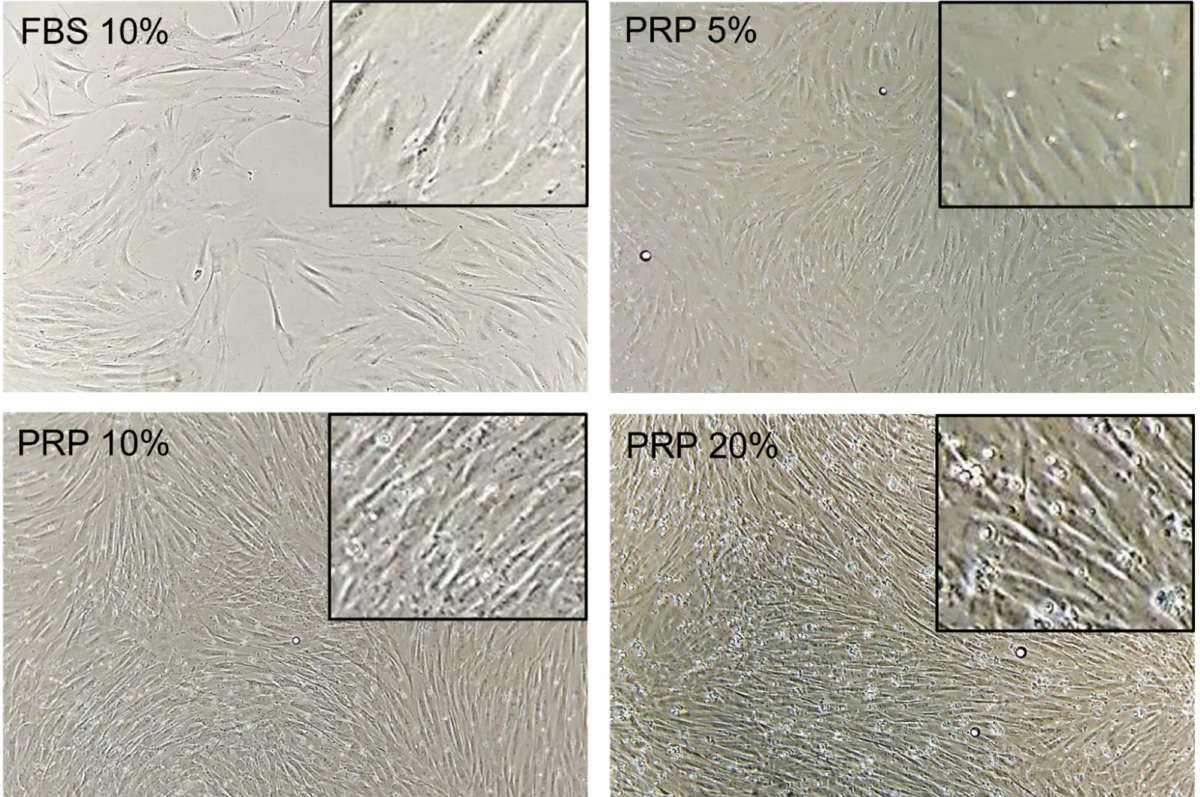
Figure 8. Bright-field optical photography of NHDF in the presence of FBS 10% or PRP (5–20%) after 7 days of culture. Magnification 10 × . Pictures are representative of one donor. Data from Berndt et al. Tissue Engineering. Part A. 2019